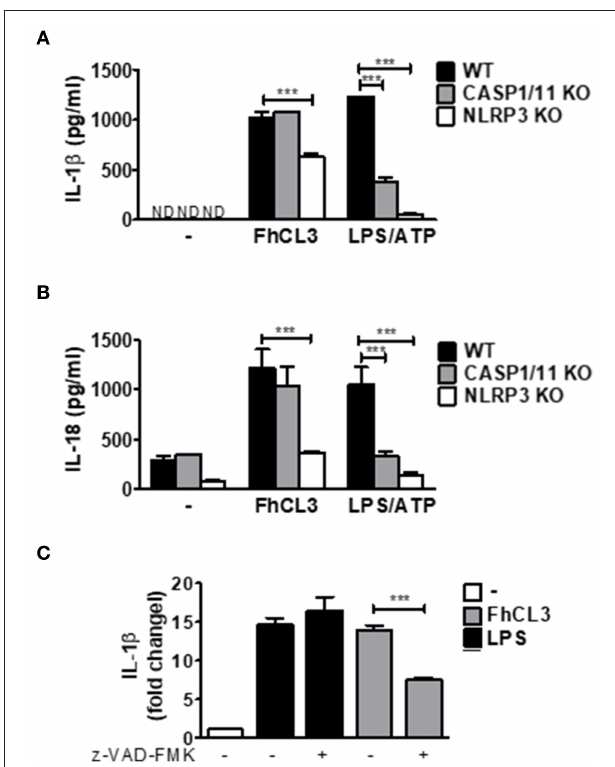
FIGURE 4 | FhCL3 enhances IL-1 β and IL-18 secretion in DCs by a NLRP3 dependent and caspase independent mechanism. (A) and (B) DCs from WT, CASP1/11 KO or NLRP3 KO mice were stimulated with medium or FhCL3 (10 µ g/mL) for 18h. In some cultures the cells were treated with LPS (100ng/mL) for 18h and ATP (5mM) for the last 30min of culture. IL-1 β and IL-18 production were evaluated by ELISA in culture supernatants. Bars panels represent the mean ± SD from three independent assays ND, not detected; *** p < 0.001(ANOVA with Dunnett’s post-test). (C) DCs pretreated or not with pan caspase inhibitor (Z-VAD-FMK, 5 µ M, 1h) were incubated with FhCL3 or LPS in the presence or absence of ATP during the last 30min of a 18h stimulation period. IL-1 β secretion was quantified by ELISA in supernatants. The bars represent a ratio of IL-1 β detected in culture supernatant of DCs with different stimuli vs. unstimulated DCs. Experiment was repeated three times with similar results being obtained and is expressed in bars graph, as the mean ±